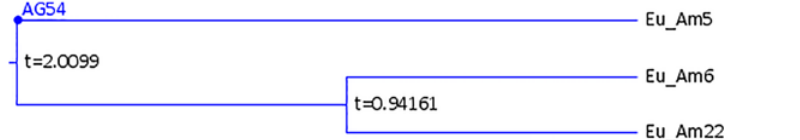
Fig 4. Enlarged Selection from Hapmap